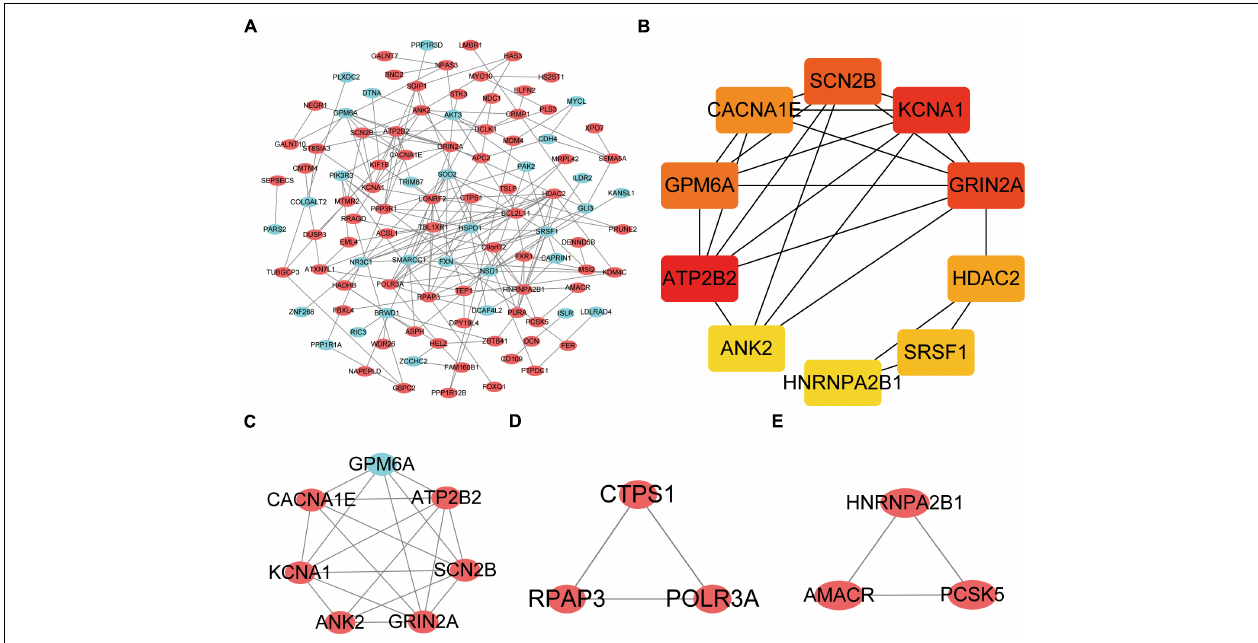
FIGURE 6 | Protein–Protein Interaction Network, Hub Genes and Key Modules. (A) The whole PPI Network. The 74 orange red nodes in the network represent up-regulated genes and the 31blue nodes in the network represent down-regulated genes. (B) PPI network of the 10 hub genes. (C) PPI network of module 1. (D) PPI network of module 2. (E) PPI network of module 3.